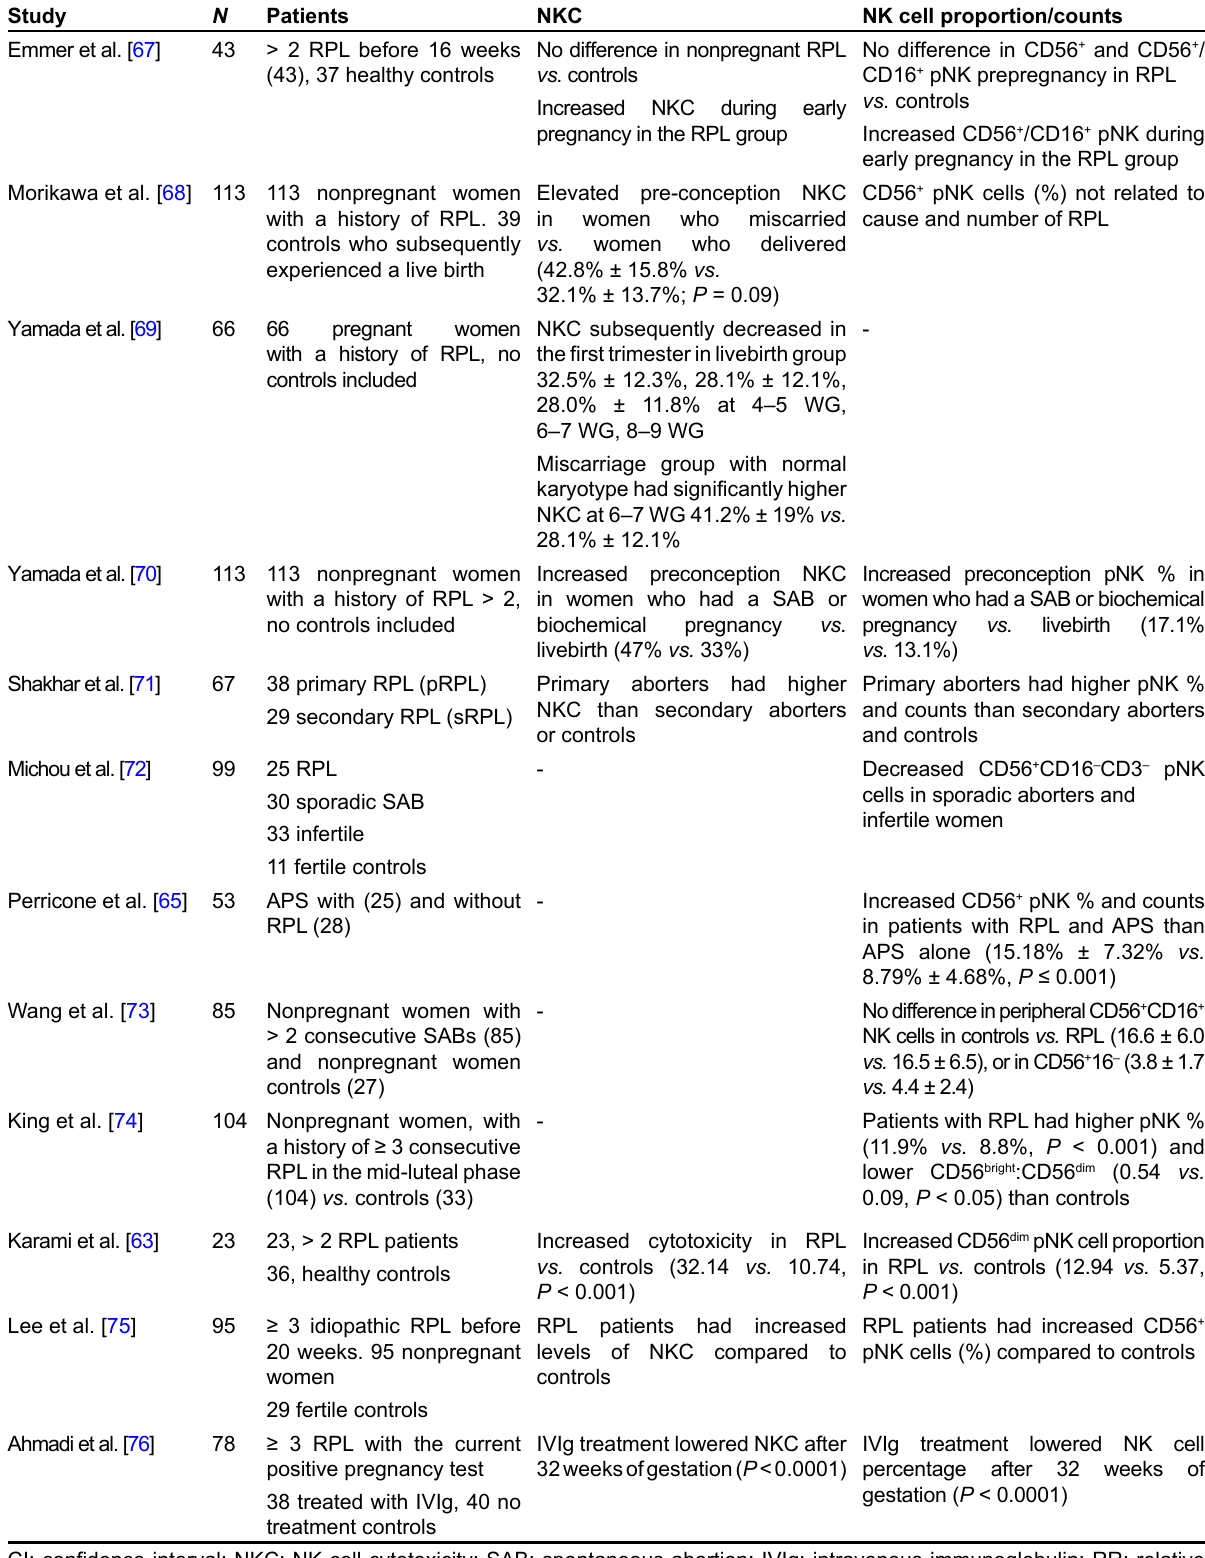
Table 2. Summary of studies evaluating pNK cell cytotoxicity (pNKC) and proportions in women with a history of RPL ( continued )